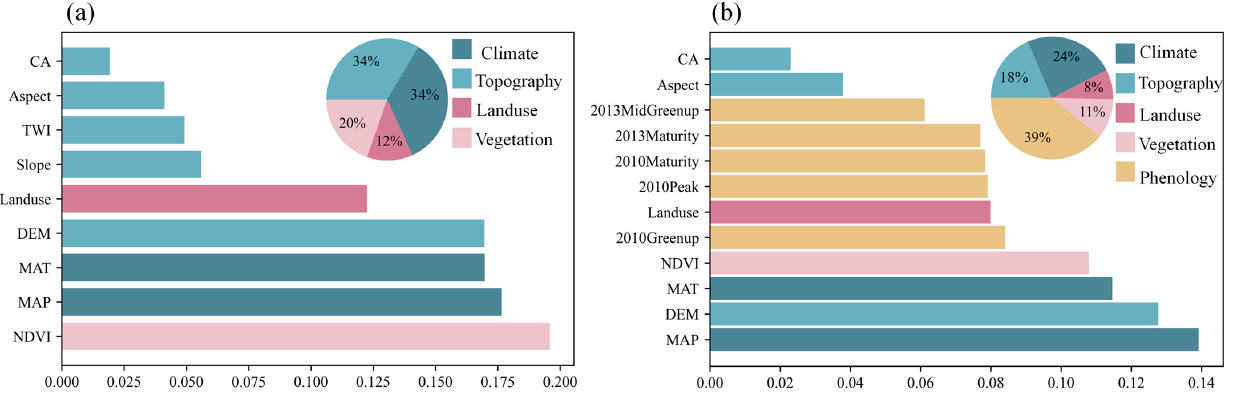
Figure 8. Importance ranking of environmental variables by RF using commonly used variables ( a ) and commonly used variables and phenological variables ( b ).